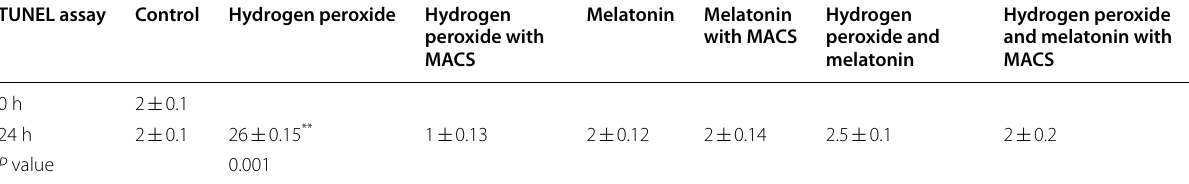
Table 1 The percentage mean of spermatozoa in 0 h and 24 h within the whole sample and the annexin V MACS–generated subpopulations in samples